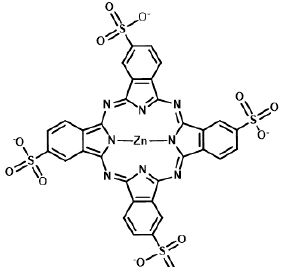
Figure 6. Chemical structure of zinc(II) phthalocyanine 3,4 ″ ,4 ″ ,4 ′″ -tetrasulfonic acid, tetrasodium salt (ZnAPC).